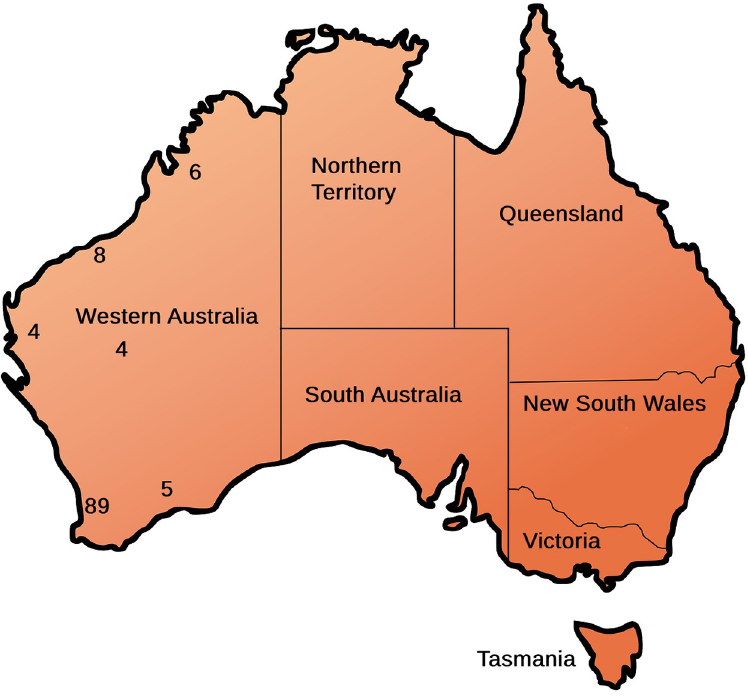
Fig 1. Geographical location of the private and public hospitals in WA. Base image by OpenClipart-Vectors from Pixabay.